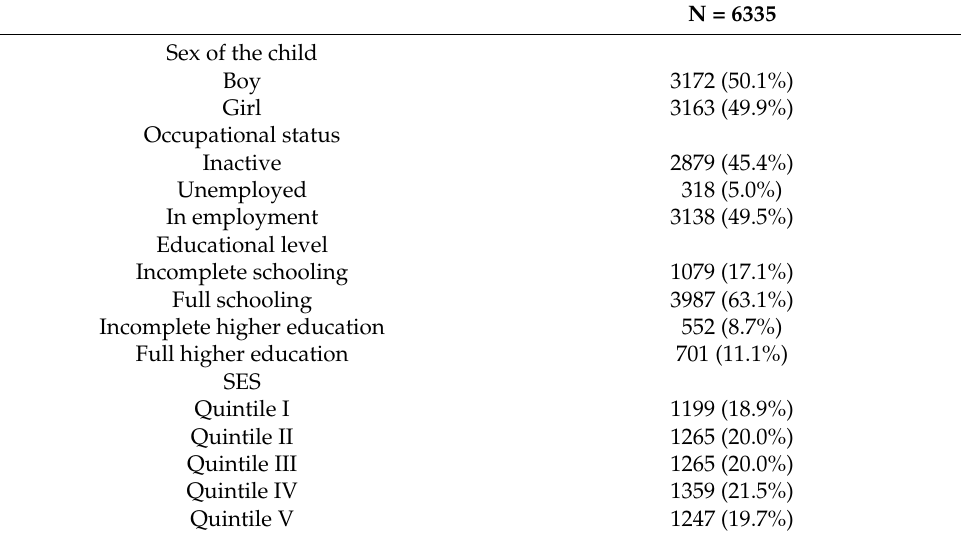
Table 1. Descriptive